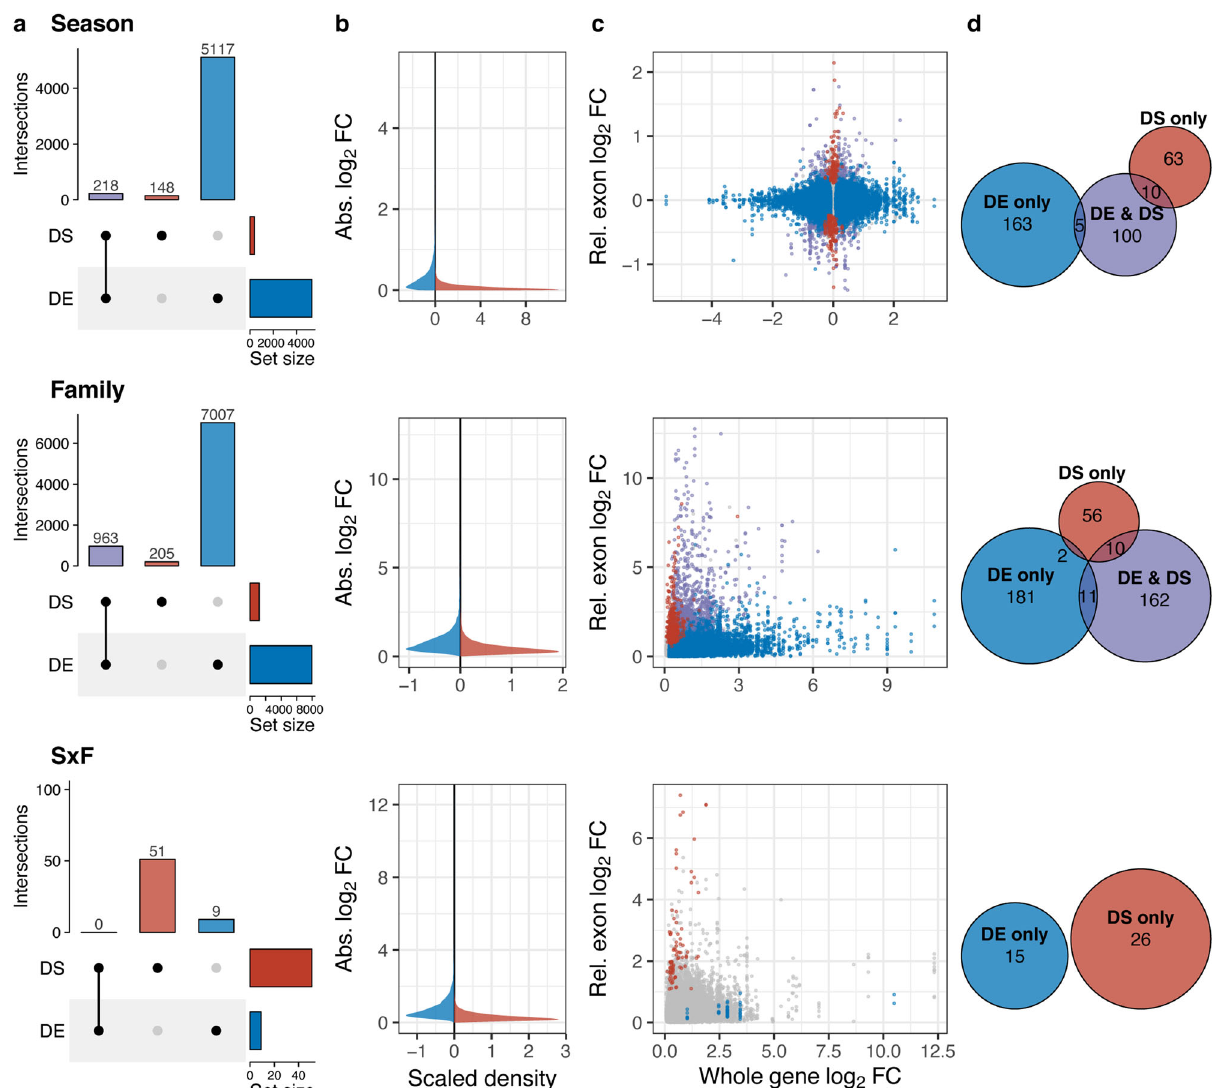
Fig. 2 Alternative splicing plays a smaller but complementary role to whole gene expression in seasonal plasticity. Results presented are for the abdomen, similar patterns were found in the thorax samples (Supplementary Fig. 2 – 6). a There was signi fi cantly more pairwise overlap (purple) of differentially spliced (DS, differential exon expression; red) and differentially expressed (DE, differential whole gene expression; blue) gene sets for the main effects of season, (one-sided Fisher ’ s exact test, OR = 1.45, P = 1.5 × 10 − 2 , Supplementary Table 4) and family (one-sided Fisher ’ s exact test, OR = 1.57, P = 1.70 × 10 − 7 ) than predicted from the size of the fi ltered datasets, while genes with a season-by-family interaction (SxF) in splicing or expression did not overlap at all. b Effect sizes of differential splicing (e.g., relative exon log fold changes, red) were generally smaller than those of differential expression (e.g., whole gene log fold change, blue). For seasonal comparisons, fold change represents the change in expression from dry to wet. For family comparisons and SxF interaction, we used the maximum absolute fold change among all families as a proxy for fold change. c There was no relationship between whole gene log fold change and exon log fold changes when compared between season, among families or SxF. d Euler diagrams show that very few gene ontology (GO) terms enriched for genes that are differentially expressed (blue), both differentially expressed and differentially spliced (purple), or only differentially spliced (red) overlapped between these gene sets. Circle sizes correspond to the total number of enriched GO terms (two-sided Fisher ’ s Exact Tests, parentChild algorithm, p-value < 0.05), and in cases where the number of shared terms is very small, the number has been placed adjacent to the intersection. Source data are provided as a Source Data fi